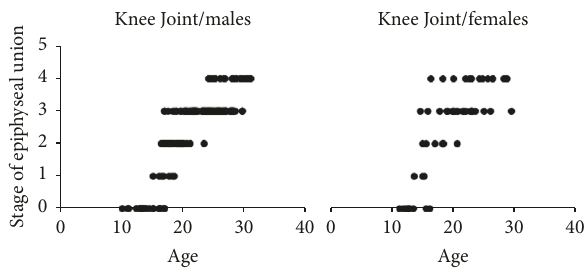
Figure 5: The graphical presentation of our sample range of age in the different epiphyseal union stages in knee